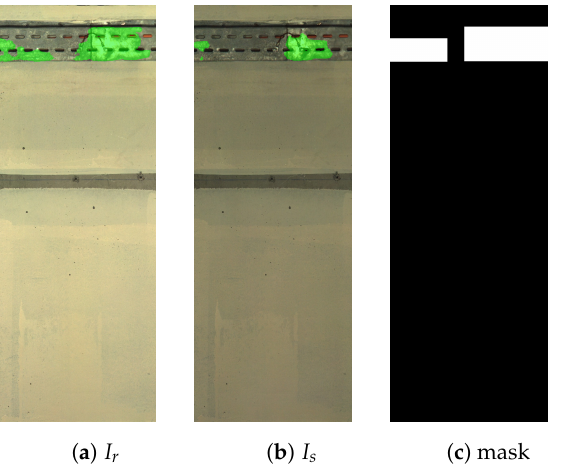
Figure 5. Highlight localisation on the reference image I r ( a ), survey image I s ( b ) and the correspond- ing highlight mask ( c